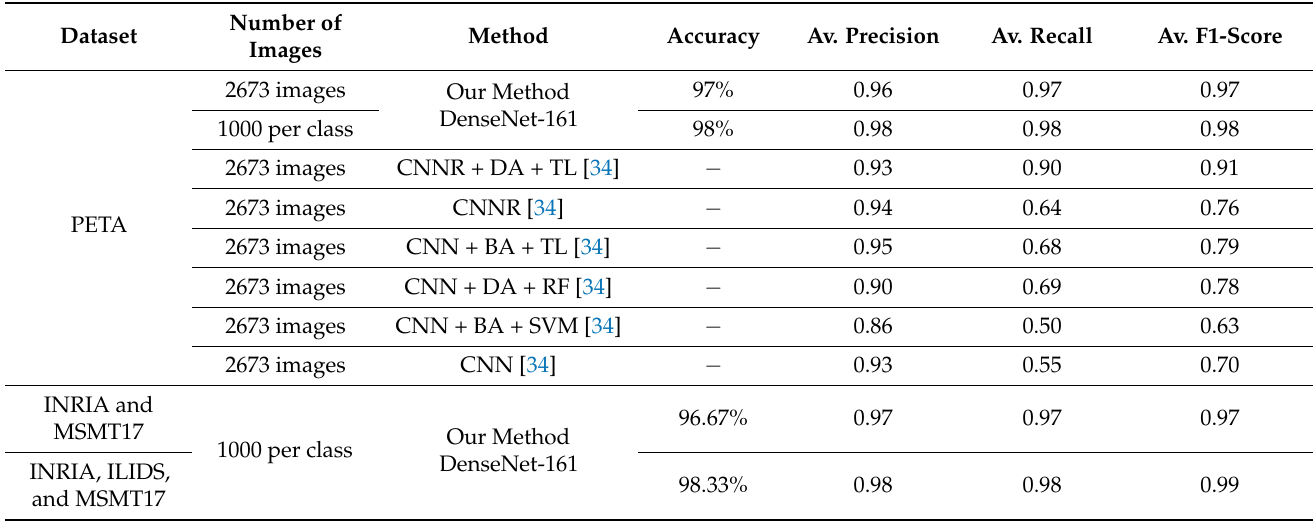
Table 20. Comparison for